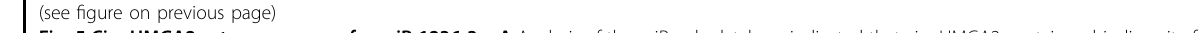
(Supporting Fig. S3B). These fi ndings indicated that circ- HMGA2 promotes LUAD cell metastasis by inducing EMT.